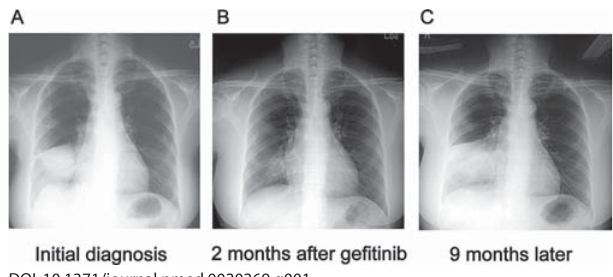
Figure 1. Chest Radiography Chest radiography shows a large mass in the RLL before gefi tinib treatment (A), and marked decrease in tumor size two months